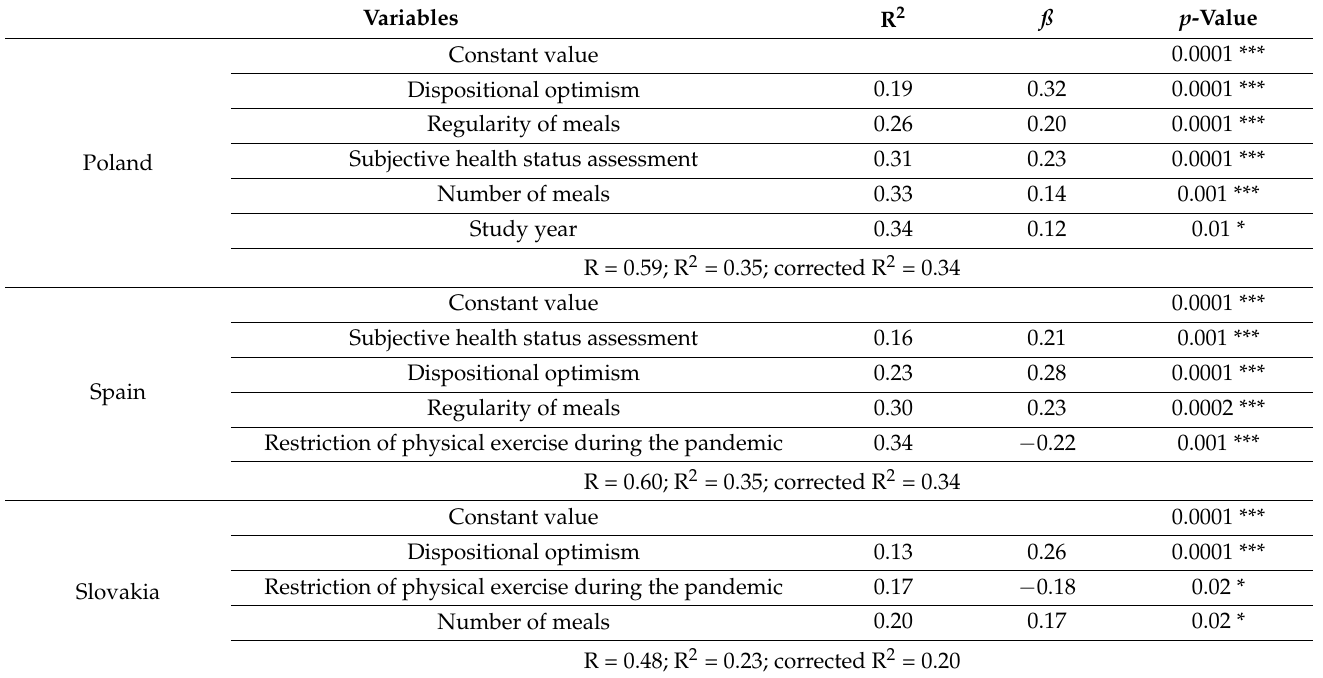
Table 4. Predictors of overall health behaviours among Polish, Spanish and Slovak nursing students: Multiple regression